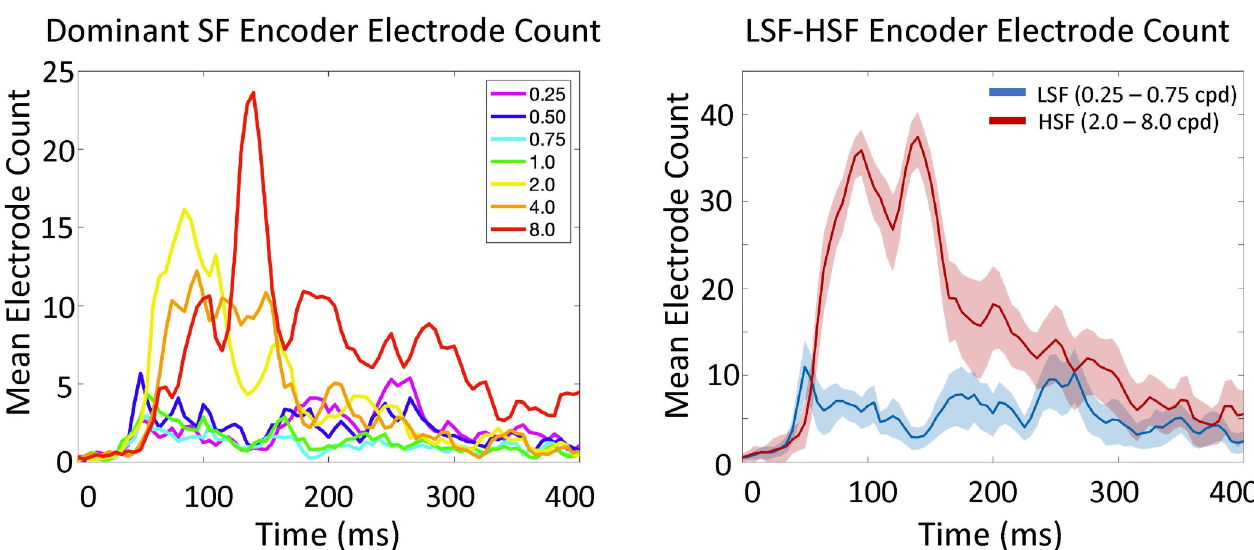
Fig 6. Participant averaged electrode counts based on encoder dominated DETI maps. The left-hand plot shows the number of electrodes that were dominated (largest sum) by each of the seven encoders. The right-hand side is a summary of that plot and shows the electrode counts summed over LSFs (0.25– 0.75 cpd) and HSFs (2.0–8.0 cpd). The shaded area shows the 95% confidence intervals over participants.